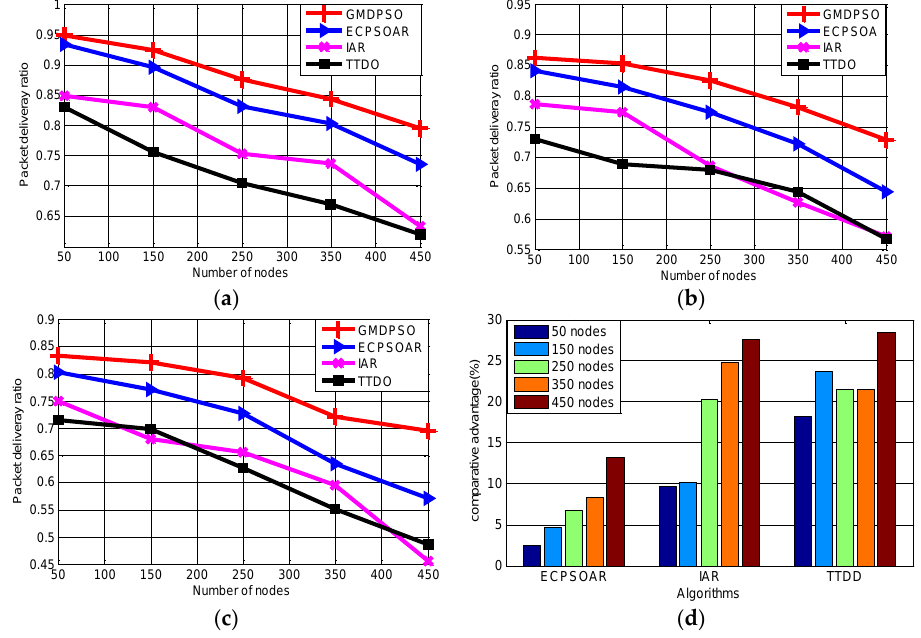
Figure 7. Average packet delivery ratio with respect to different node failure probabilities. ( a ) When the node failure probability is 0.01; ( b ) When the node failure probability is 0.02; ( c ) When the node failure probability is 0.04; ( d ) Average PDR comparative advantage. Table 4. Average packet delivery ratio (PDR) with respect to different P fault